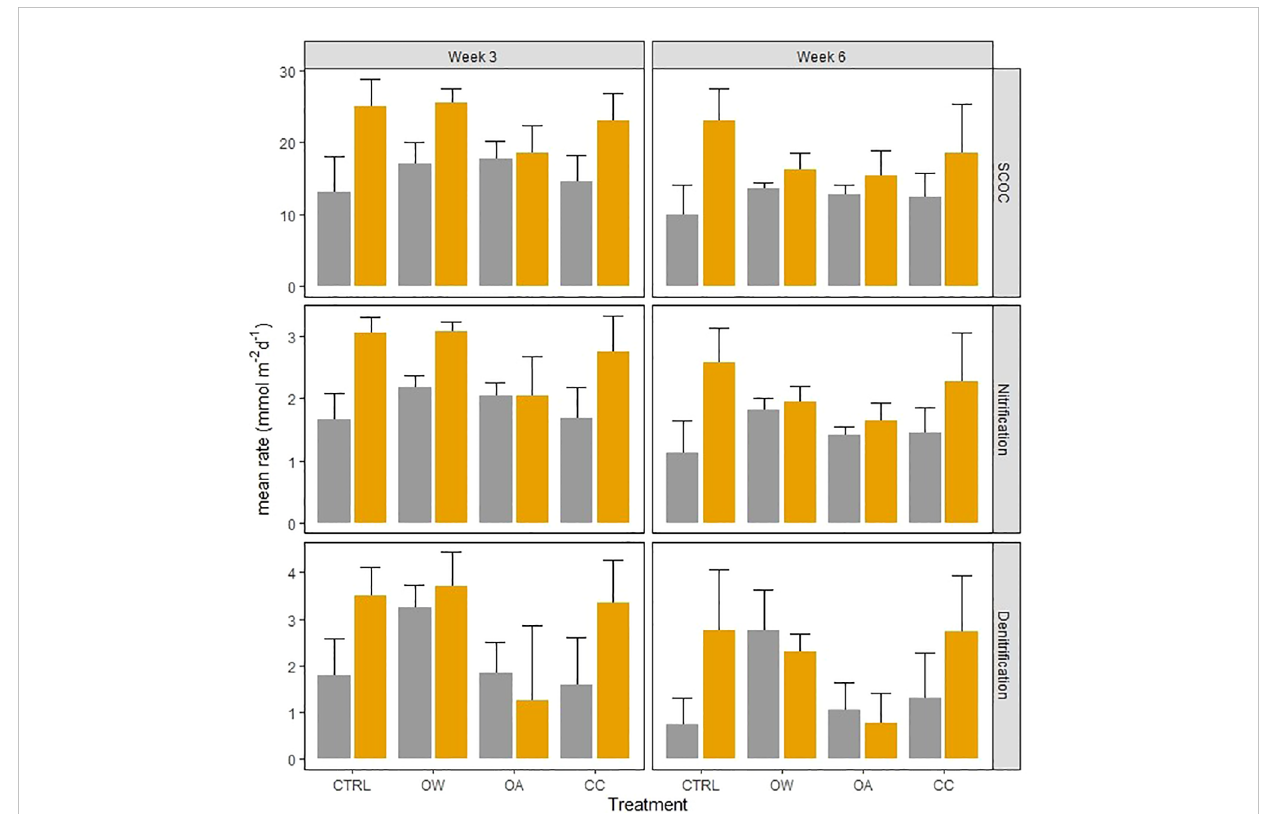
FIGURE 4 Effect of Abra alba presence (present: orange bars, absent: grey bars) on sediment community oxygen consumption (SCOC, mmol O 2 m -2 d -1 ), nitri fi cation and denitri fi cation rates (mmol N m -2 d -1 ), in 4 different treatments at 2 different times. Error bars represent standard errors (±